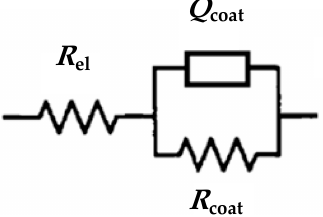
Figure 7. Electrical equivalent circuit used to fit impedance spectra shown in Figure 6a,b.